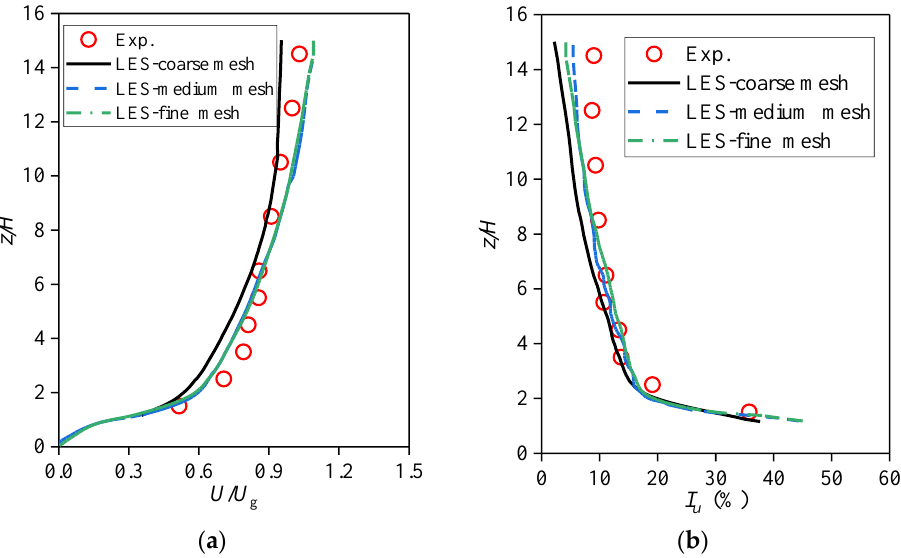
Figure 10. Approaching flow characteristics obtained from LES and experiment with models mounted. ( a ) U / U g ( b ) I u . Table 2. Validation metrics for wind speeds U and turbulence intensities I u for LESs.